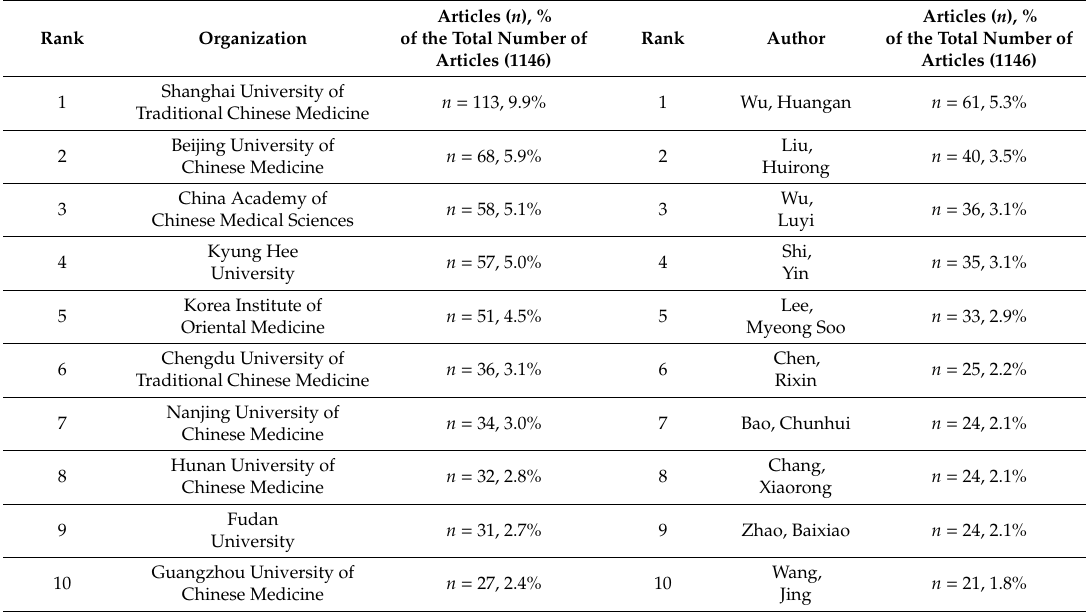
Table 4. The top 10 organizations and authors producing the highest number of original and review articles investigating